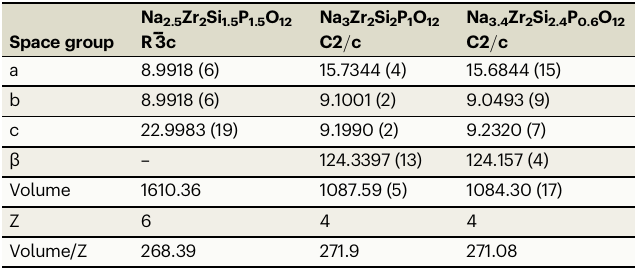
Table 1 | Lattice parameters of selected NASICON samples obtained from PXRD at about 298 K